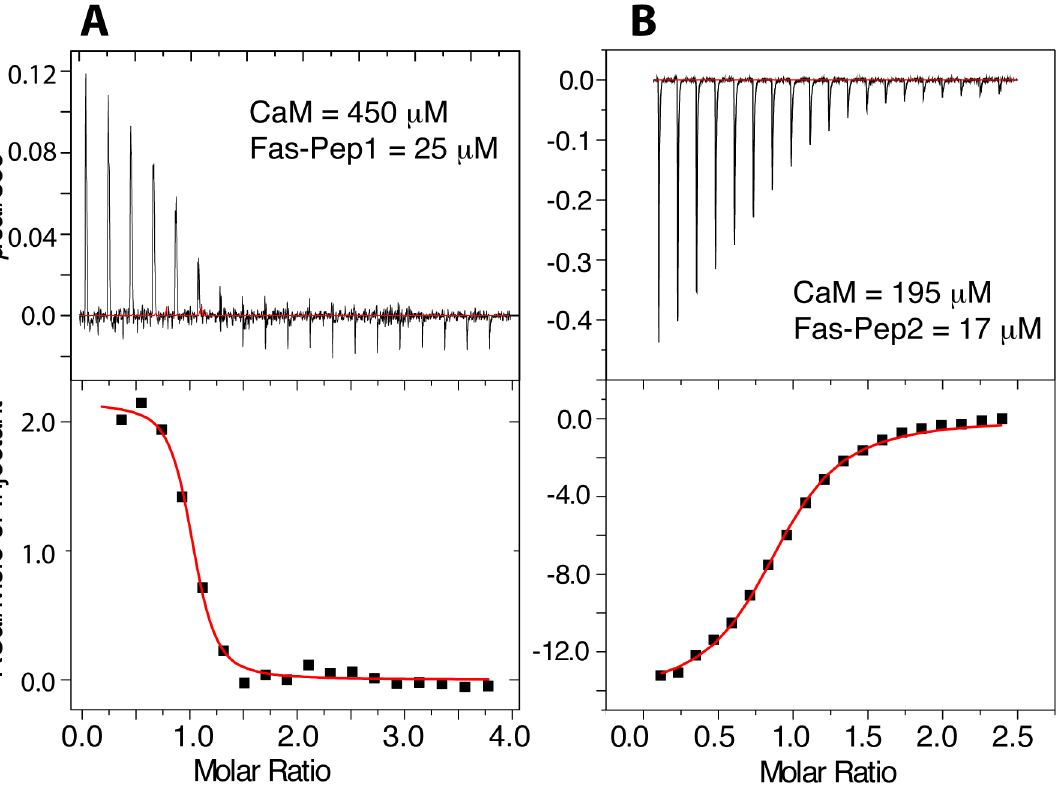
Fig 4. ITC data of Ca 2+ /CaM binding to FasDD peptides. ITC data obtained for titration of ( A ) Ca 2+ /CaM at 450 μ M into Fas-Pep1 at 25 μ M, and ( B ) Ca 2+ / CaM (195 μ M) into Fas-Pep2 at 17 μ M. Data fitting afforded K d values of 0.3 and 1.1 μ M for Fas-Pep1 and Fas-Pep2, respectively.